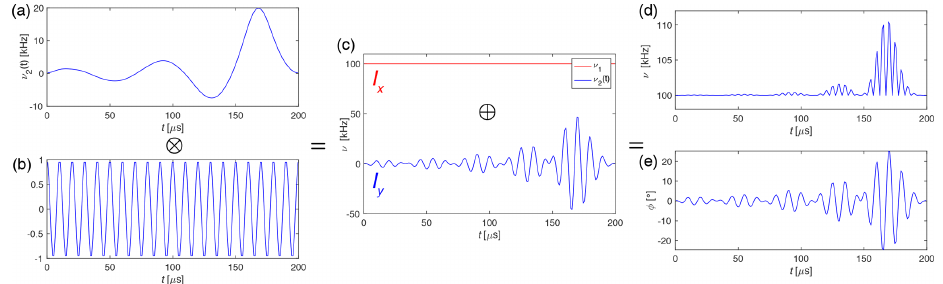
Figure 1. Generating the I-BURP-2 pulse in the spin-lock frame with a 100kHz spin-lock field, 200µs pulse length, 100kHz modulation frequency and time resolution of 1µs. (a) Pulse shape of the I-BURP-2 pulse which is multiplied by the (b) frequency modulation and leads to the (c) y component (blue) of the rf field. The spin lock is the x component (red) of the rf field. The two components are combined and result in (d) the amplitude and (e) phase of the final pulse shape that can be used in the experiment. The time resolution for the shapes was usually set to 1µs.